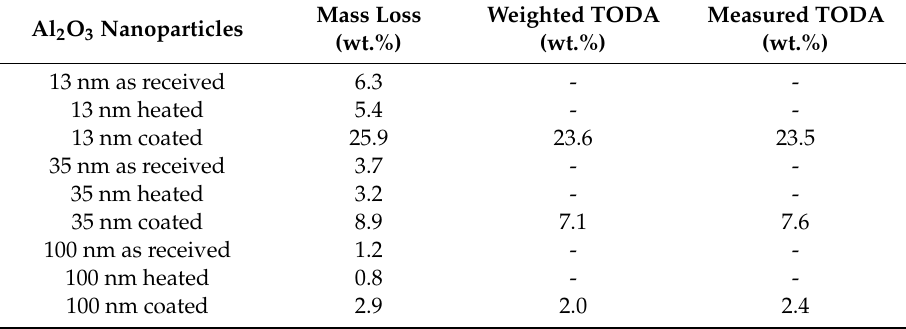
Figure 4. Particle size reduction in the ball mill for the 13 nm ( a ), 35 nm ( b ) and 100 nm ( c ) sized particles over a timeframe of 8 h. Table 2. Maximum mass loss of as-received, heated and coated fillers during thermogravimetric analysis. The weighted TODA concentration, i.e., the amount of dispersant added during ball milling, is related to the TODA concentration measured in the